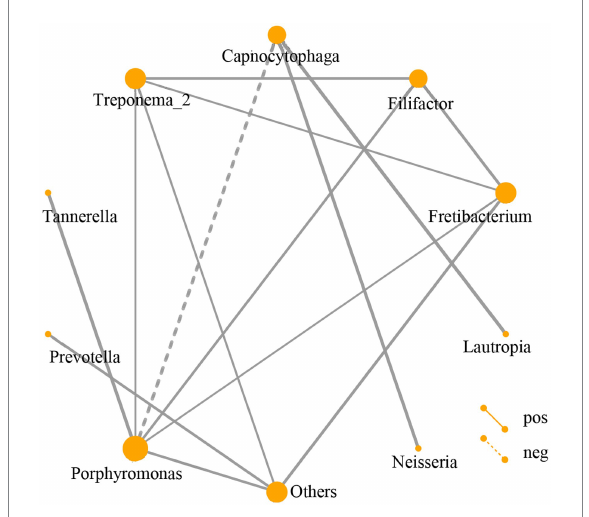
FIGURE 5 Network analysis of subgingival dominant bacteria genera. Different nodes represent different dominant bacterial genera. The connection between the nodes indicates that there is a correlation between the two genera. By default, we display the relationship pair with a correlation coefficient |rho| > 0.4, and the thickness of the line indicates the strength of the correlation. The thicker the line, the stronger the correlation; the thinner the line, the weaker the correlation. Solid lines indicate positive correlations, dashed lines indicate negative correlations. The size of the node represents the abundance of the flora, the greater the abundance, the larger the node; the lower the abundance, the smaller the